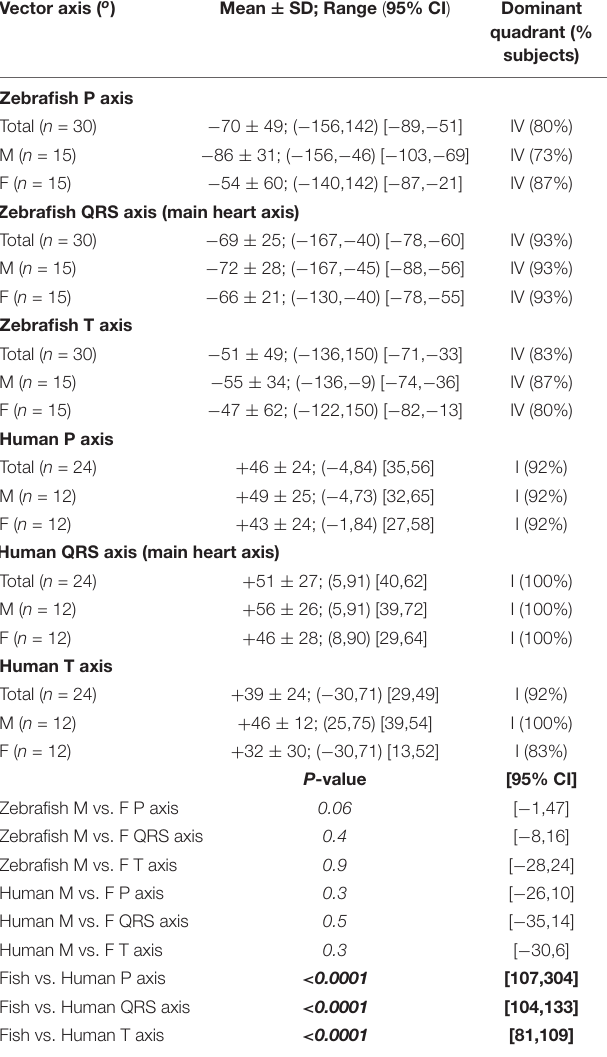
TABLE 4 | Electrical heart axes in the frontal plane of zebrafish vs. humans. Vector axis ( o ) Mean ± SD; Range ( 95% CI ) Dominant